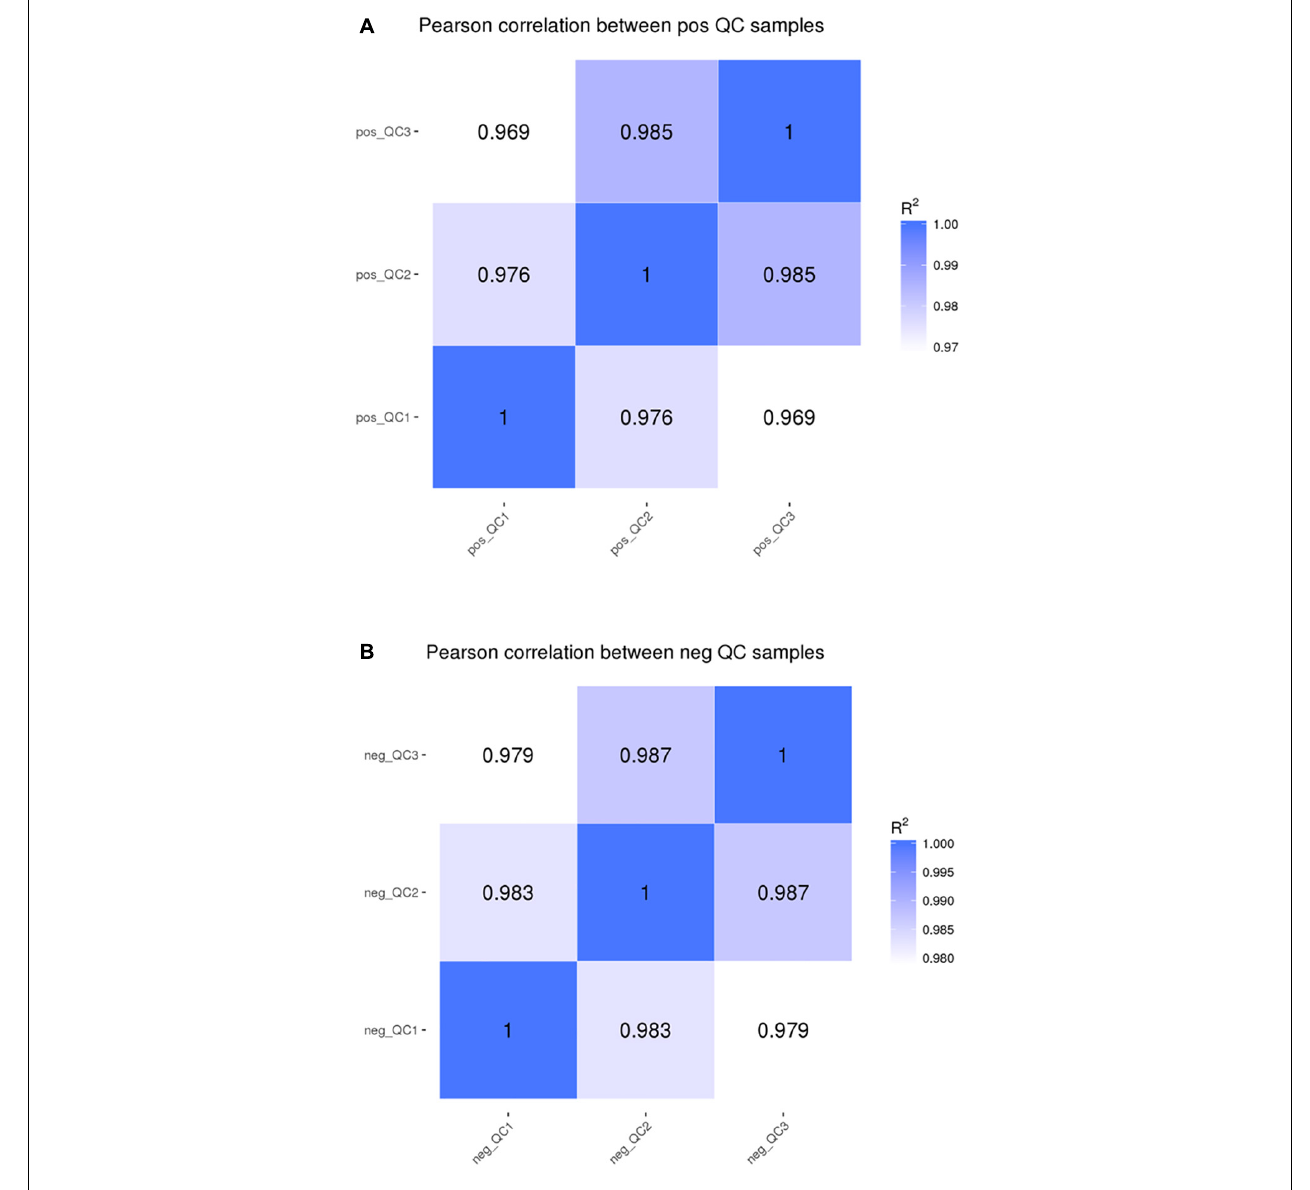
FIGURE 6 | The quality control (QC) (A) chart positive ion mode (B) and negative ion